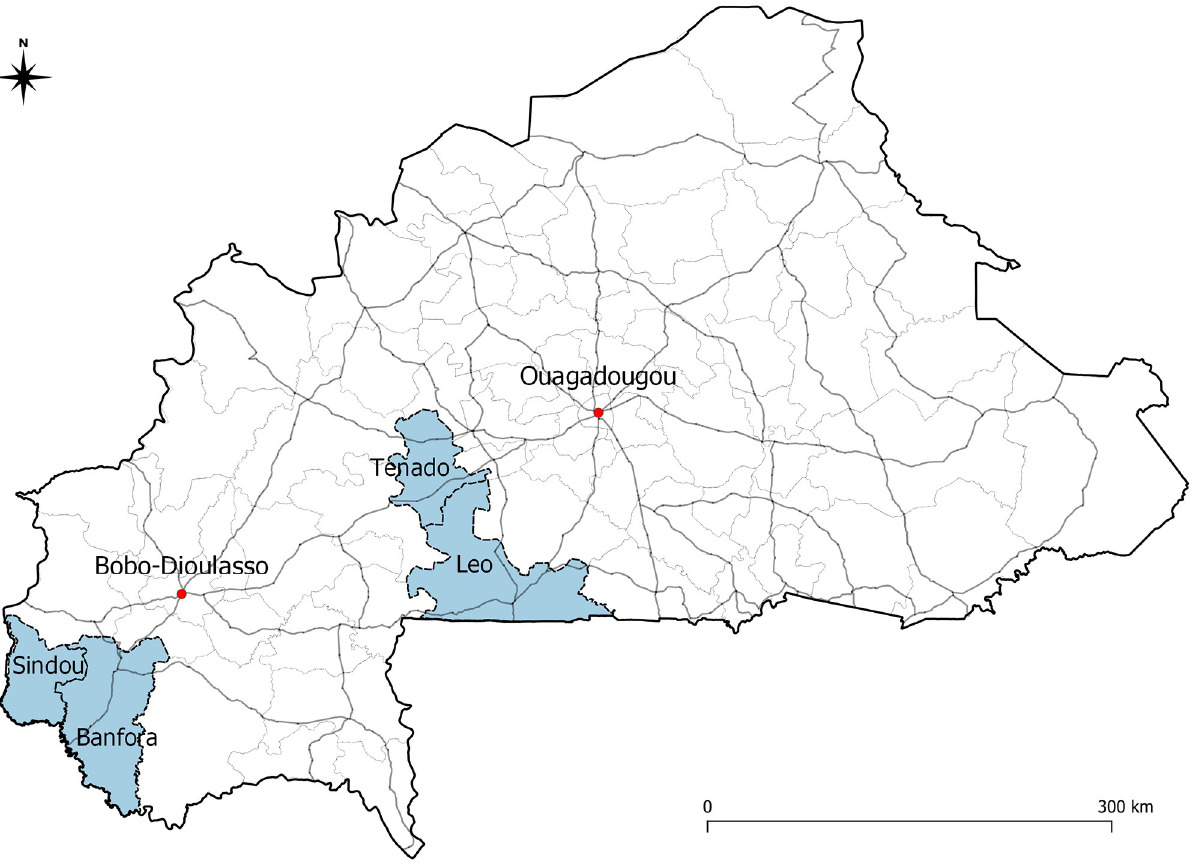
Fig 1. Map of study area. The four health districts are displayed in blue. Main roads are shown as gray lines. Data and layers used to create this map are available at: https://data.humdata.org/dataset/burkina-faso-administrative-boundaries.